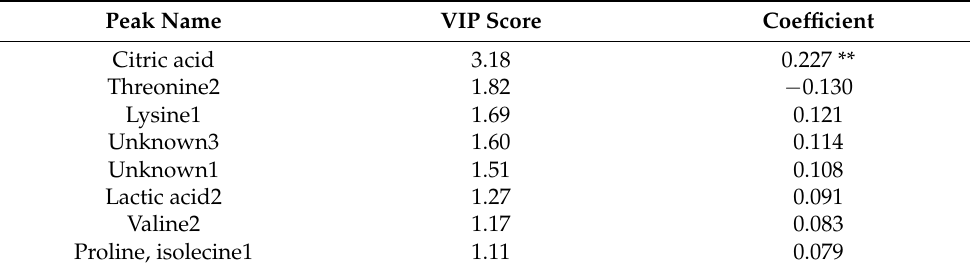
Table 2. Substances with VIP scores greater than 1.0 in the PLS-DA